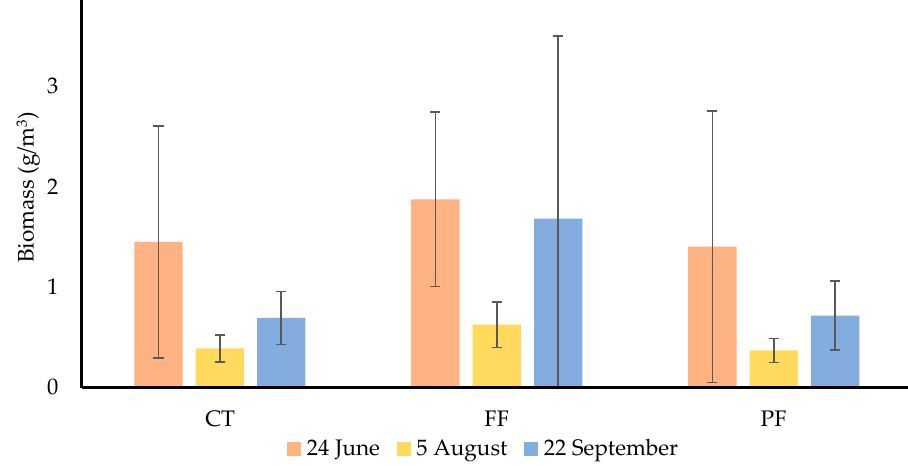
Figure 3. Average biomass of the zooplankton species per treatment at each sampling time; CT— Control; FF—Fishmeal-based feed; PF—Plant meal-based feed.